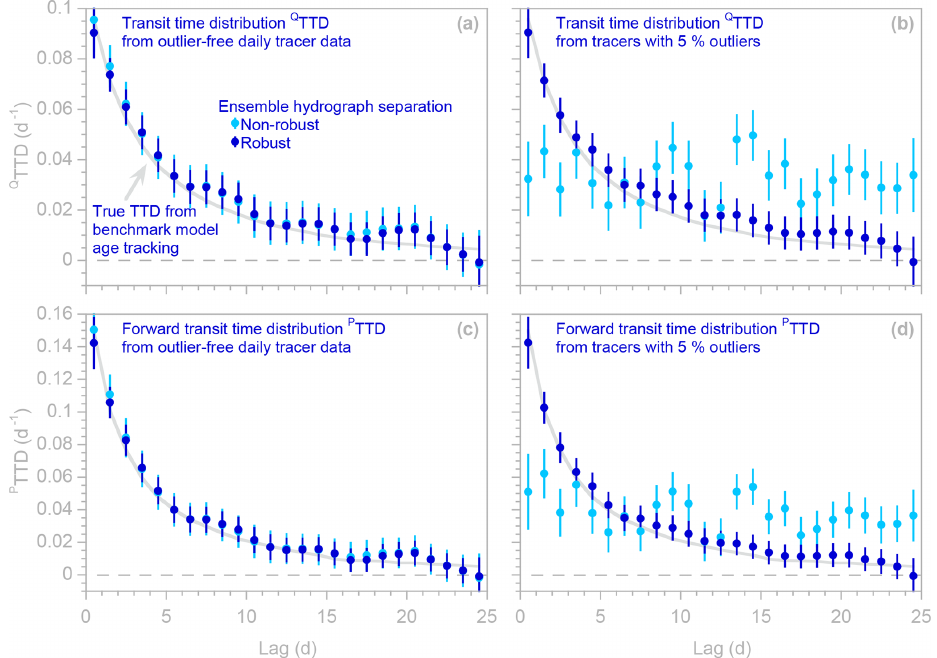
Figure 5. Transit time distributions of discharge ( Q TTDs; panels a and b ) and forward new water fractions of precipitation ( P TTDs; pan- els c and d ), as estimated by ensemble hydrograph separation from synthetic benchmark tracer time series without outliers (a, c) and with outliers (b, d) . Symbols show results obtained with and without robust estimation (dark and light symbols, respectively); error bars indicate 1 standard error. In (a) and (c) , many light blue symbols are obscured because they are overprinted by dark blue symbols. Light gray curves indicate the true TTDs, as calculated from water age tracking in the benchmark model. When the tracer data are free of outliers (a, c) , esti- mates obtained from robust and non-robust methods are almost equally good, both typically lying within 1 standard error of the true TTDs (gray curves). However, when the input data are corrupted by extreme outliers (b, d) , estimates from the non-robust method (light symbols) deviate substantially from the true TTDs, whereas estimates from the robust method (dark symbols) still follow the gray curve nearly as well as they did with the outlier-free